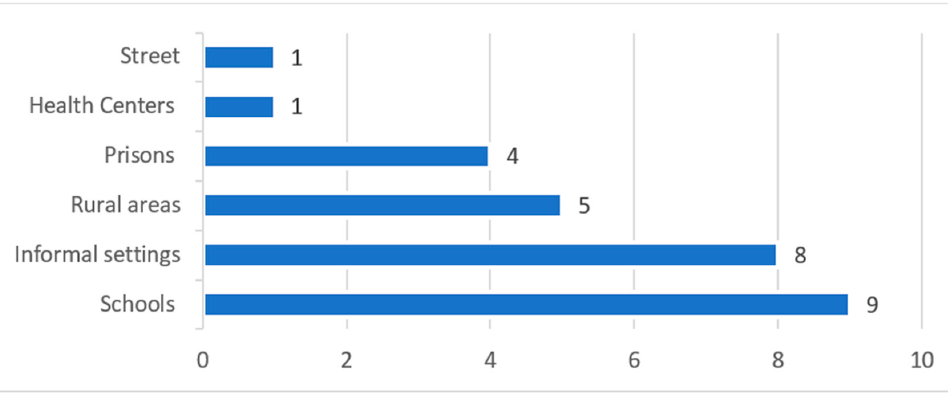
Figure 4. Number of recommendations in the SR country reports mentioning a specific group.